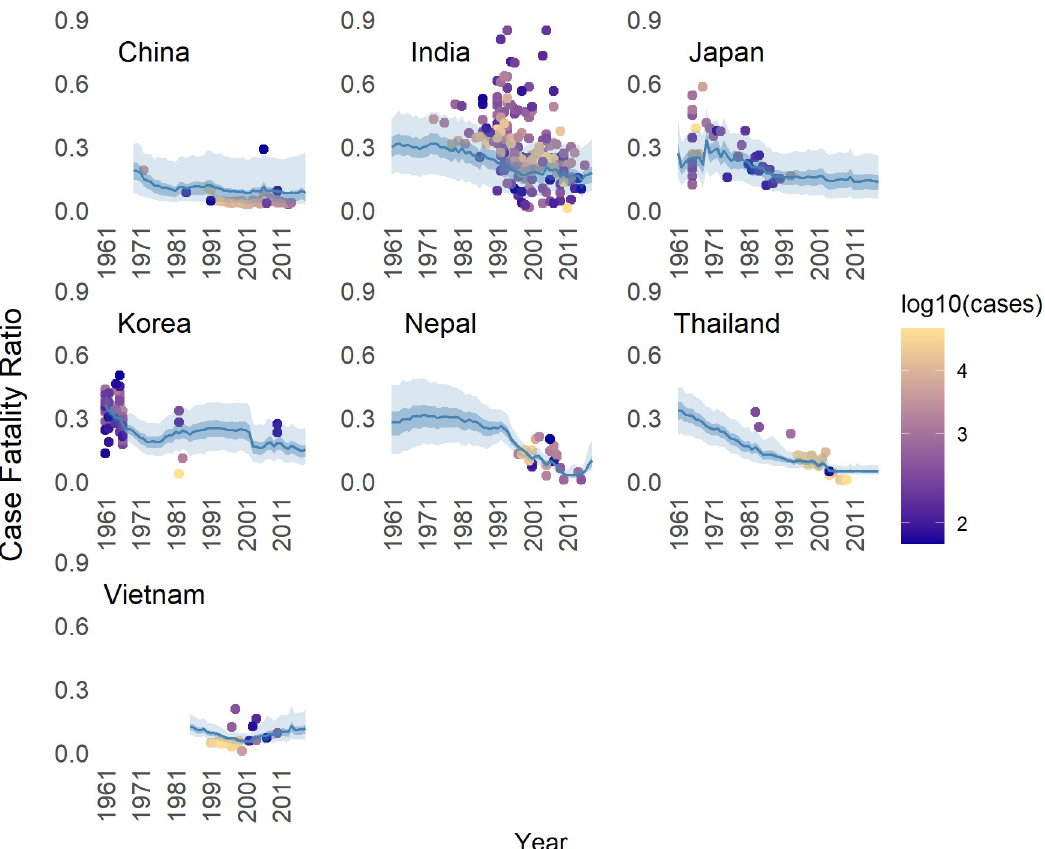
Fig 3. The Japanese encephalitis (JE) case-fatality ratio (CFR) records and the predicted JE CFRs for each JE endemic country with more than 10 JE CFR records over time using the best model (model 6). In all plotted JE endemic countries, the solid line and the lighter ribbon represent the mean predicted JE CFR with its 95% confidence interval. Darker ribbon shows the region of 1 st quartile and 3 rd quartile of predicted JE CFR. Dots represent the JE CFR records with color dependent on the value of log 10 (the number of reported JE